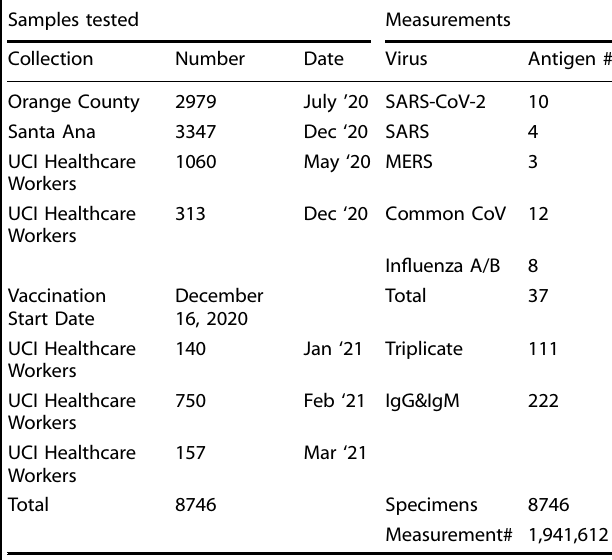
Table 1. Longitudinal study design, sample collection, and assay